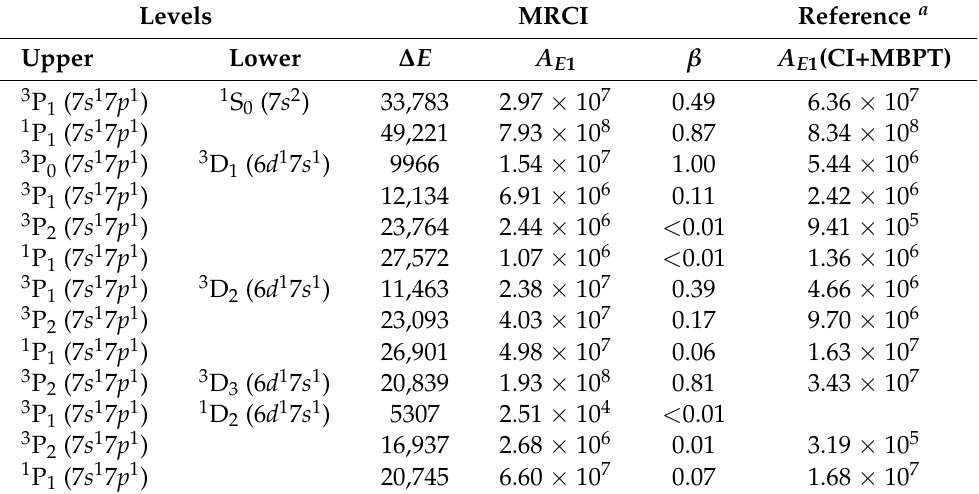
Table 5. Calculated Einstein coefficients A E 1 (in 1/s) and branching ratios β for the electric dipole’s allowed transitions in Lr + , obtained from the MRCI transition dipole moment matrix and the ∆ E (in cm − 1 ) from the complete basis set limit, compared with the reference theoretical